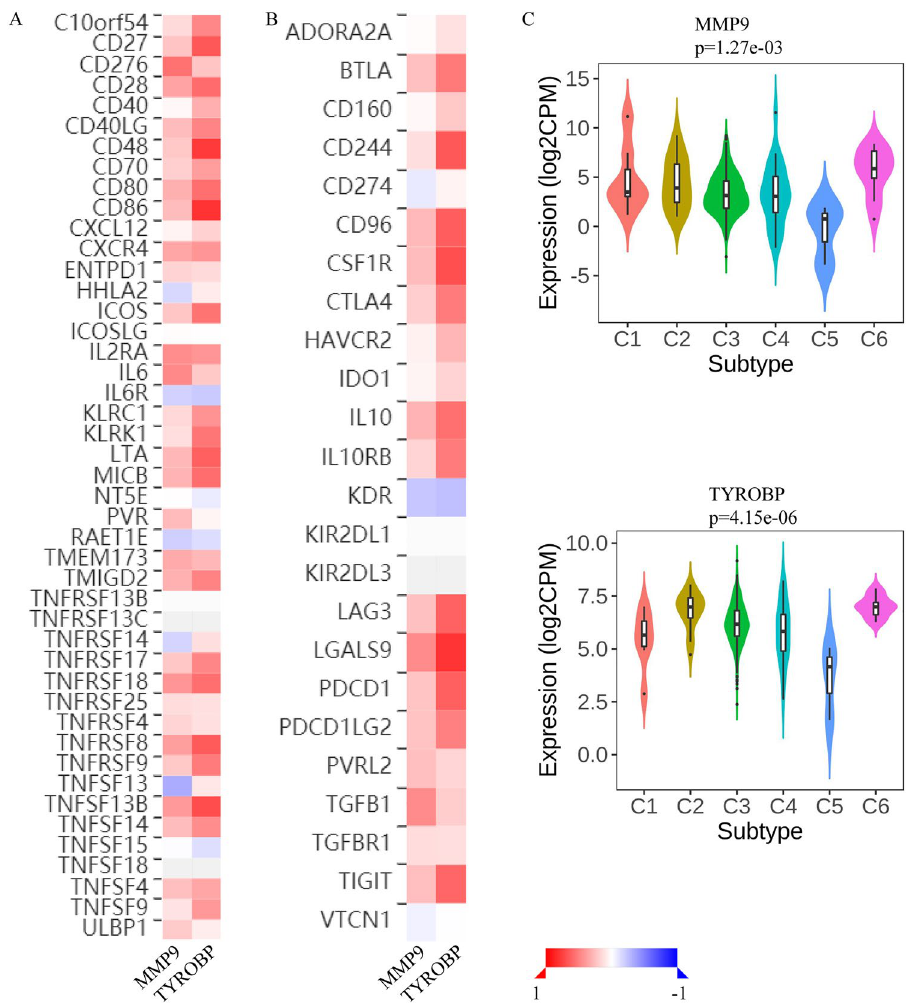
Figure 8. Immunocorrelation analysis of key genes. ( A ) Correlations between key genes and immune stimulators. ( B ) Correlations between key genes and immune inhibitors. ( C ) Association between key genes and immune subtypes of ccRCC. Red represents a positive relationship and blue represents a negative